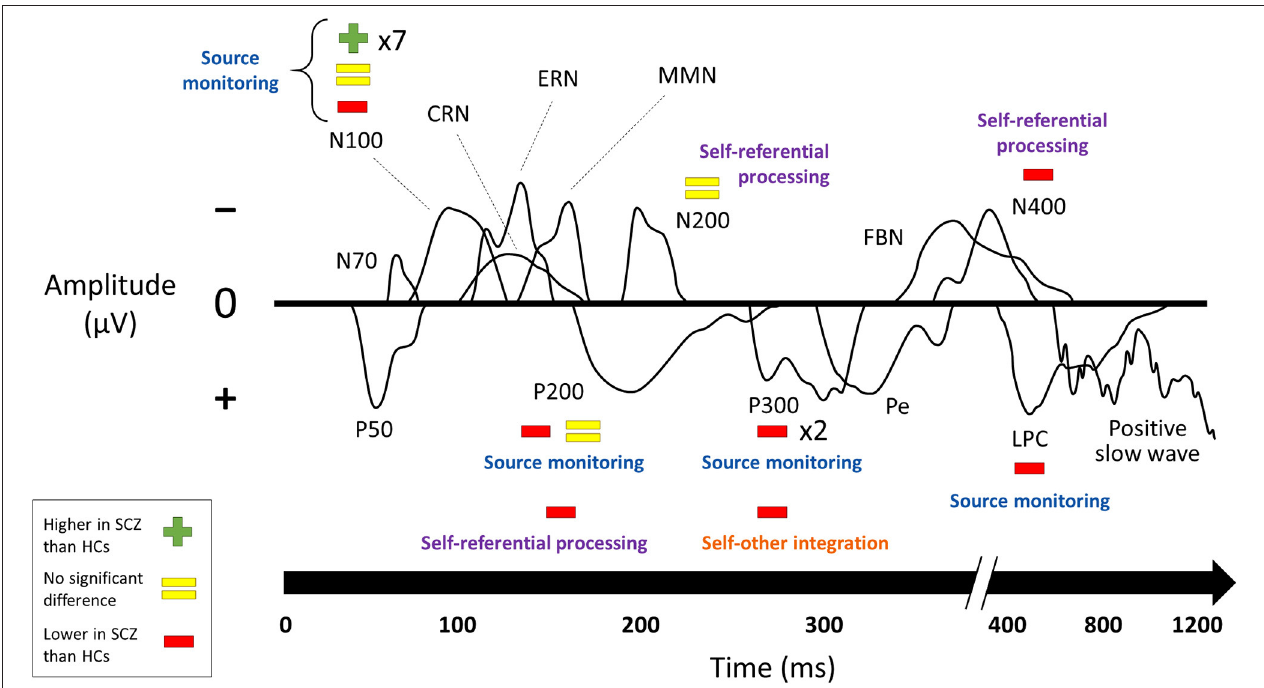
FIGURE 4 | Changes in ERP component amplitudes by paradigm. Studies that compared ERP component amplitudes in schizophrenia to those in healthy controls, excluding those that did not compare self-related task data to comparable non-self-related task data. Sorted according to the paradigms from Figure 1 . SCZ, subjects with schizophrenia. HCs, healthy controls. Multipliers beside a plus, equals, or minus sign indicate the number of studies that reported this result. The visual depictions of ERP components are stylized approximations that do not correspond to the findings of any of the studies in particular. A few ERP components were not named in the studies and were categorized here based on their latency and whether they were positive- or negative-going. Results of the individual studies can be found in the Supplementary Material .